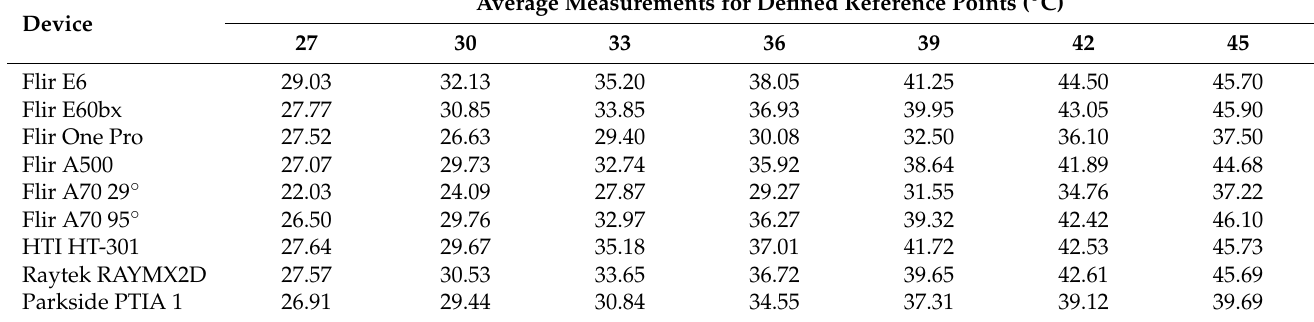
Table 5. Temperature readings during the calibration process.